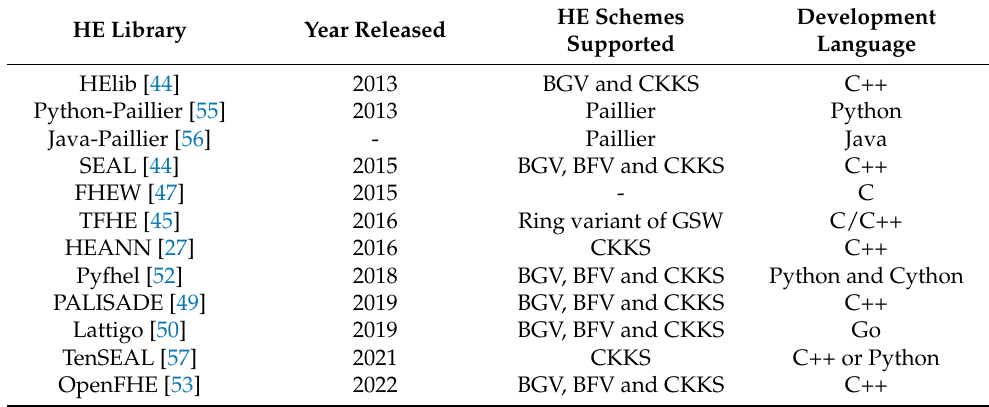
Table 1. HE libraries for biometric security (adapted from [13,15]). HE Library